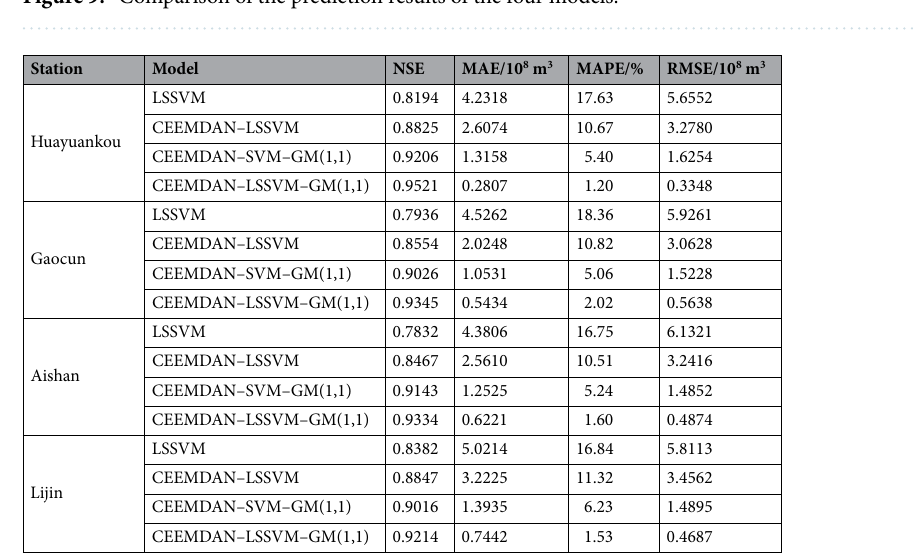
Figure 9. Comparison of the prediction results of the four models.